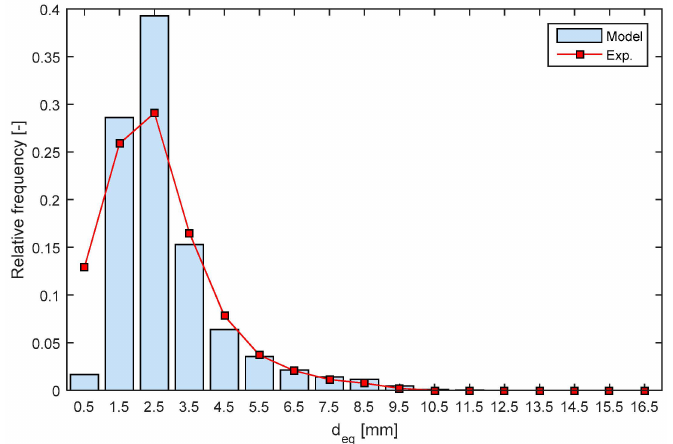
Figure 4. Comparison between PBM results and experimental data: U G = 0.0111 m/s.